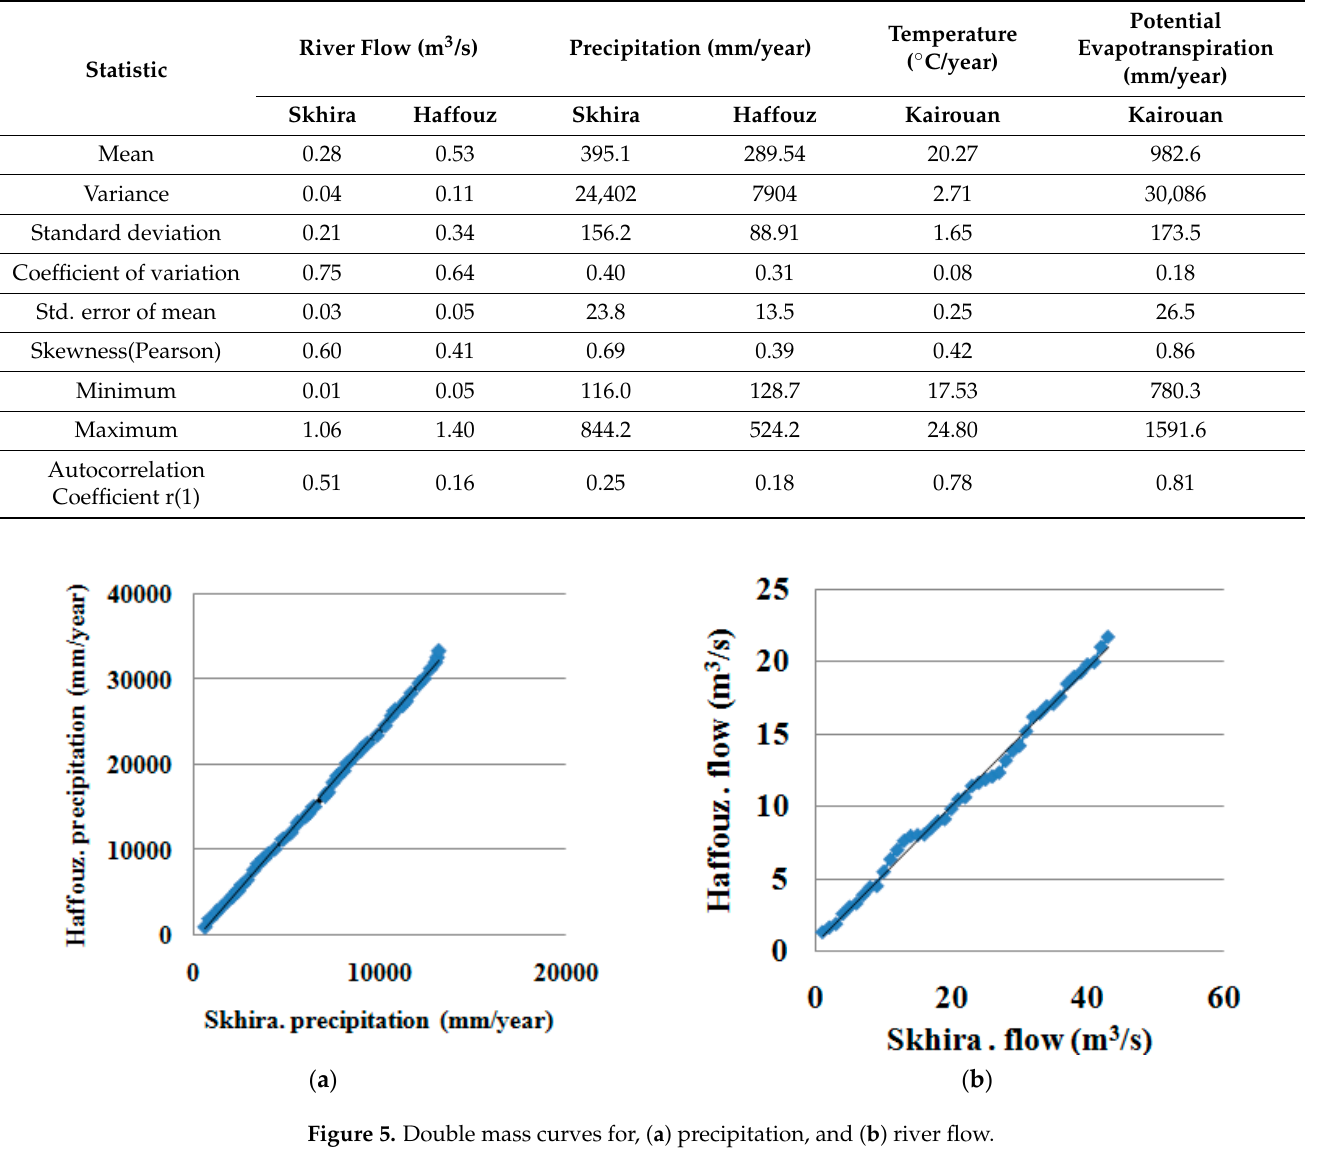
Table 2. Descriptive statistics of data used for the study period (1976–2017).